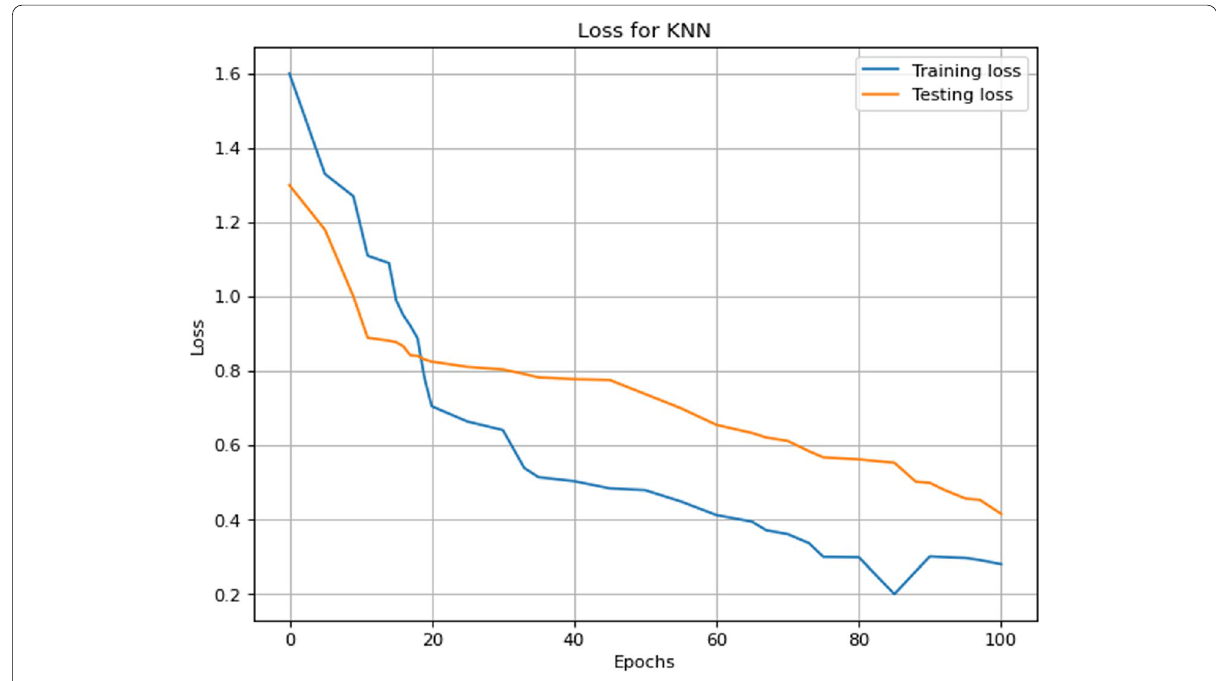
Fig. 18 Loss for our proposed model with KNN